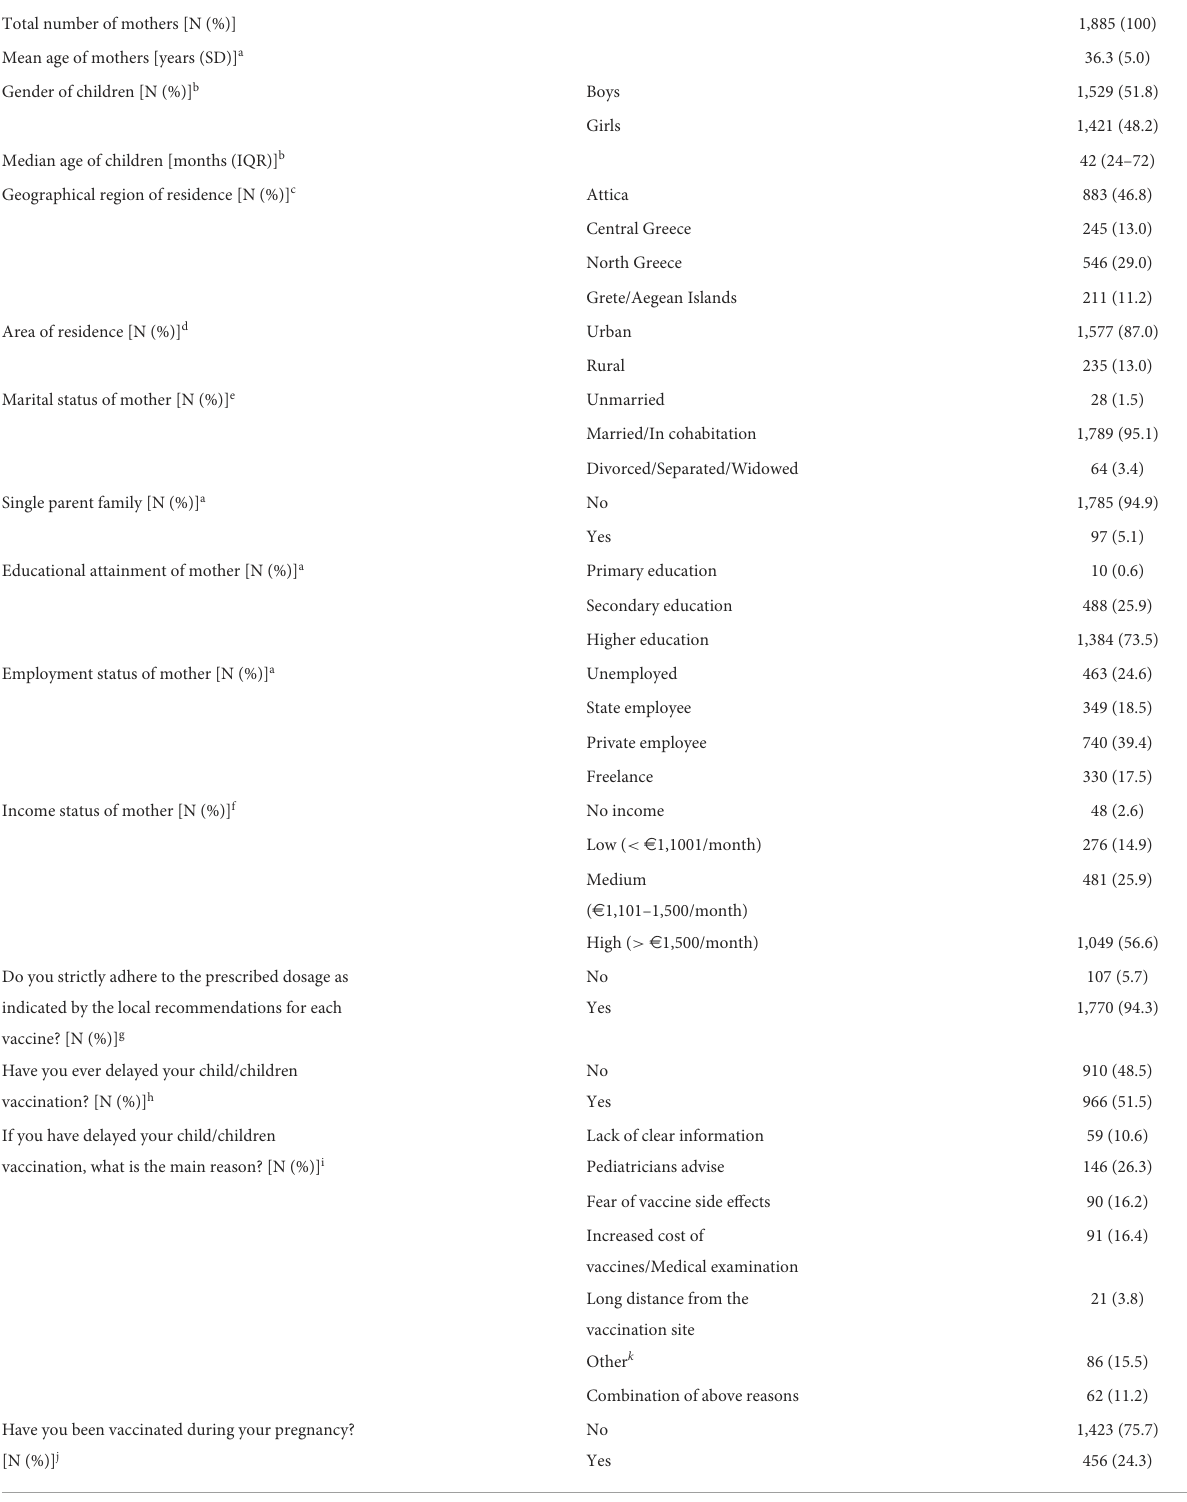
Total number of mothers [N